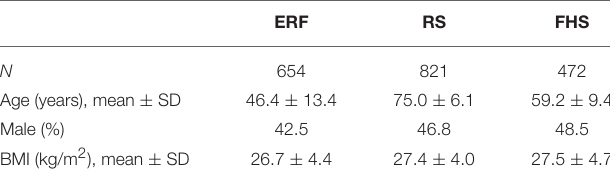
Table 1 . The mean age in RS was 75 years ( x BMI = 27.4 kg/m 2 ), TABLE 1 | Descriptive statistics of the study populations.